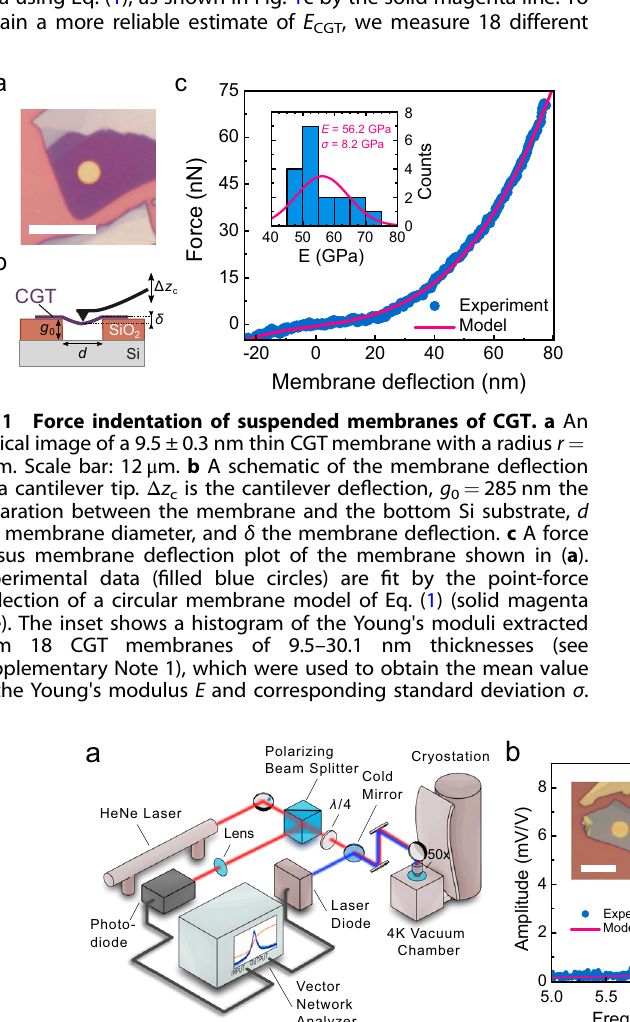
Fig. 2 CGT membrane characterization using laser interferometry. a Schematic diagram of the laser interferometry setup. b Filled blue circles — measured amplitude of the fundamental resonance peak at T = 4 K. Solid magenta line — fi t to a damped harmonic oscillator model. The inset shows an optical image of a 17.4 ± 0.3 nm thin CGT membrane of 2 μ m radius. Scale bar: 8 μ m. c The comparison of the measured resonance frequency f 0 of the thin fi lm shown in ( b ) (see also Supplementary Note 2) and the lattice constant of bulk CGT as a function of temperature. The fi lled and open blue circles represent the measured data during heating and cooling cycles respectively. The connected magenta circles represent the lattice constant a of bulk CGT as measured by Carteaux et al. 5 . The dashed black horizontal line represents a at T = 300 K. The insets show schematics of membrane stretching or buckling at tensile or compressive strain, on the right and left respectively. The pink region indicates the temperature range where compressive strain is dominant and is a guide to an